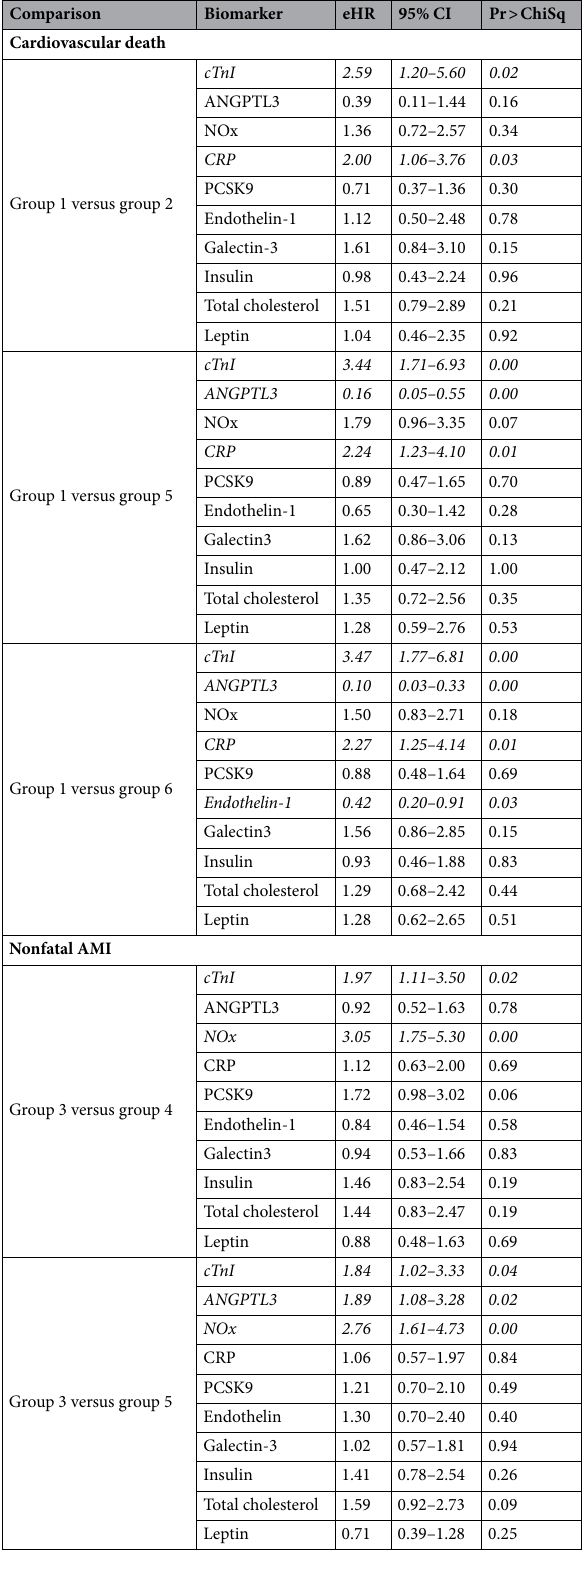
Table 4. Multivariate Cox regression analysis for associations of top 11 biomarkers with cardiovascular deaths and nonfatal AMI adjusted for sex and age. Significant values are in [italics]. PCSK9, proprotein convertase subtilisin/kexin type; ANGPTL3, angiopoietin-like protein 3; NOx, nitrate and nitrite; cTnI, cardiac troponin I; CRP, C-reactive protein; eHR, estimated hazard